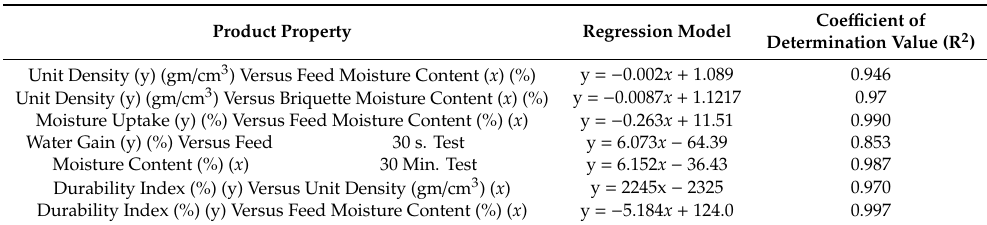
Table 4. Regression equations of the experimental data.